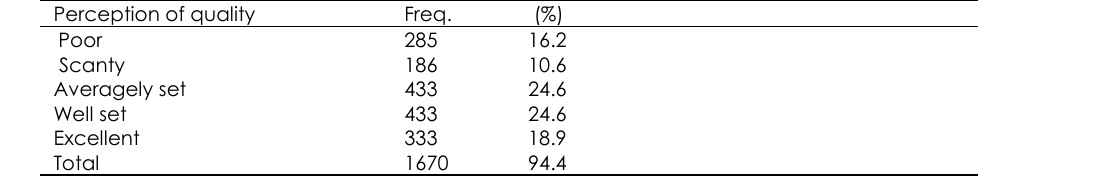
Table 2. Perception of qualities of UZGs of Federal Universities in South-west